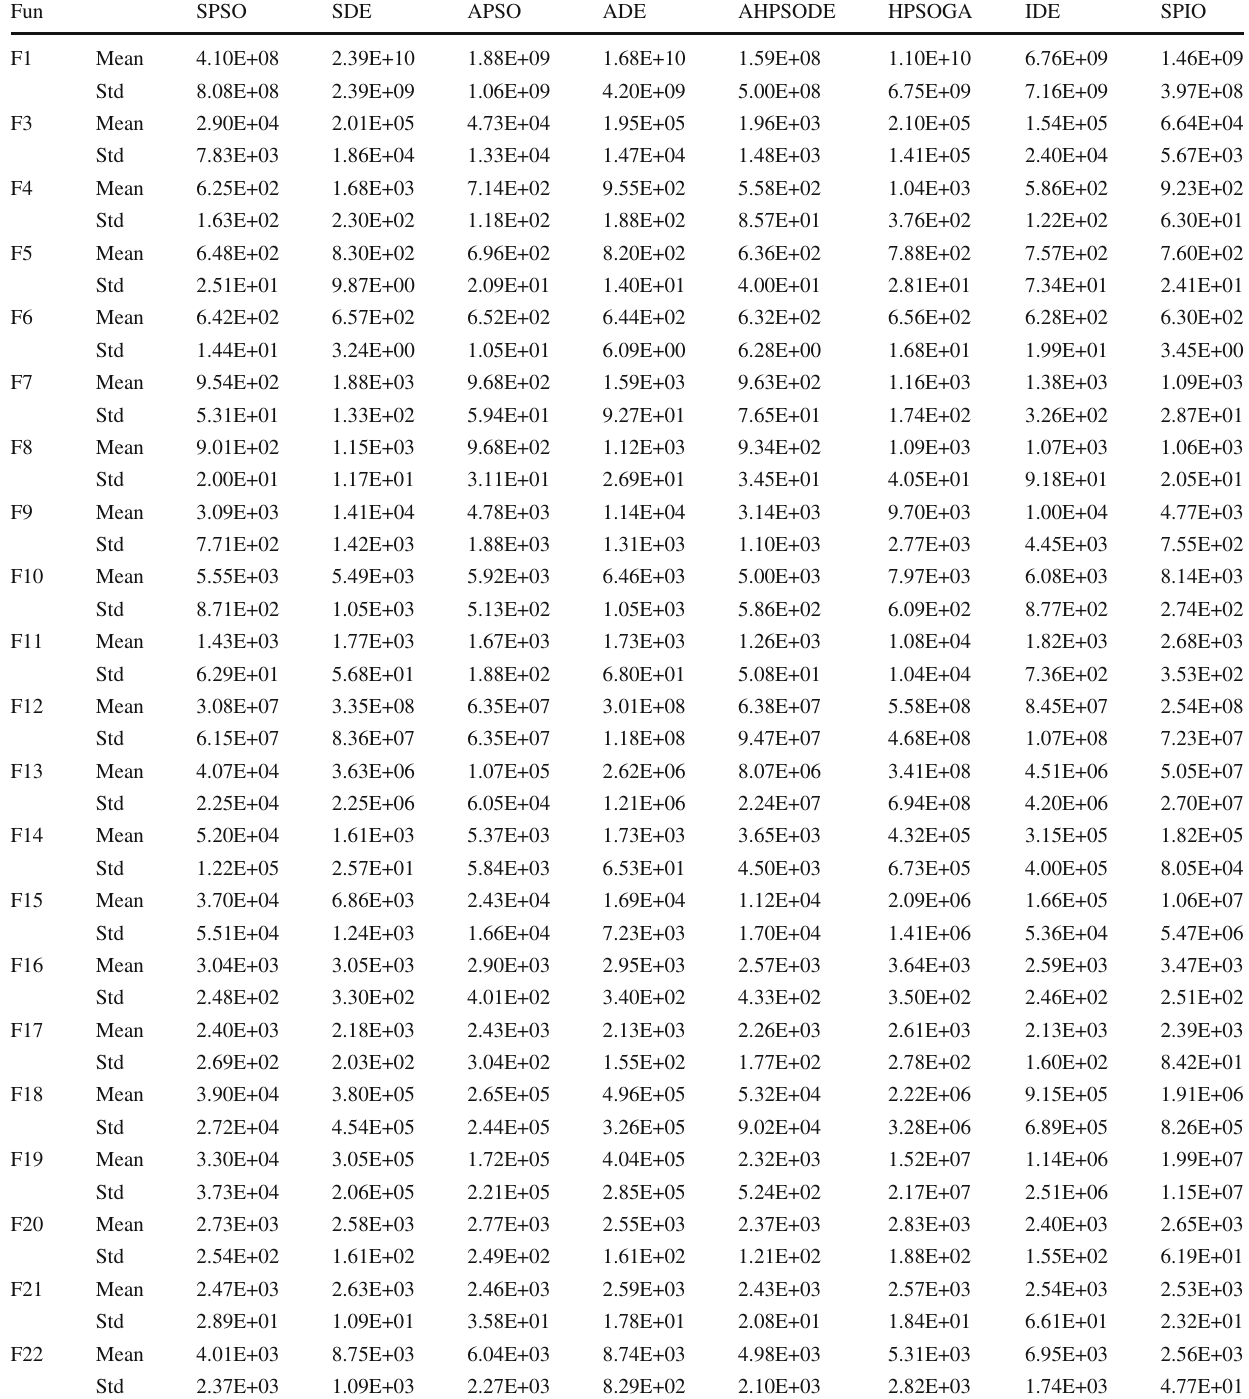
Table 14 Results on AHPSODE compared with other algorithms at